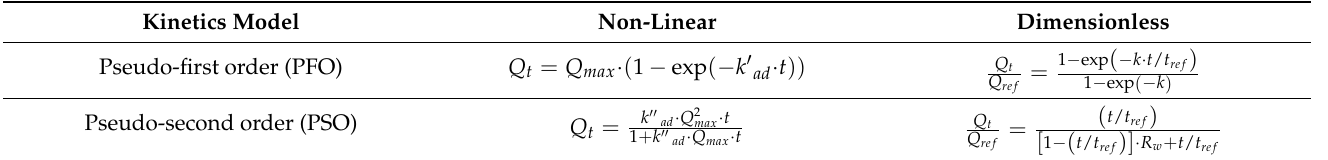
Table 7. Model equations describing the kinetics of the phenol adsorption [50,51]. Kinetics Model Non-Linear Dimensionless Pseudo-first order